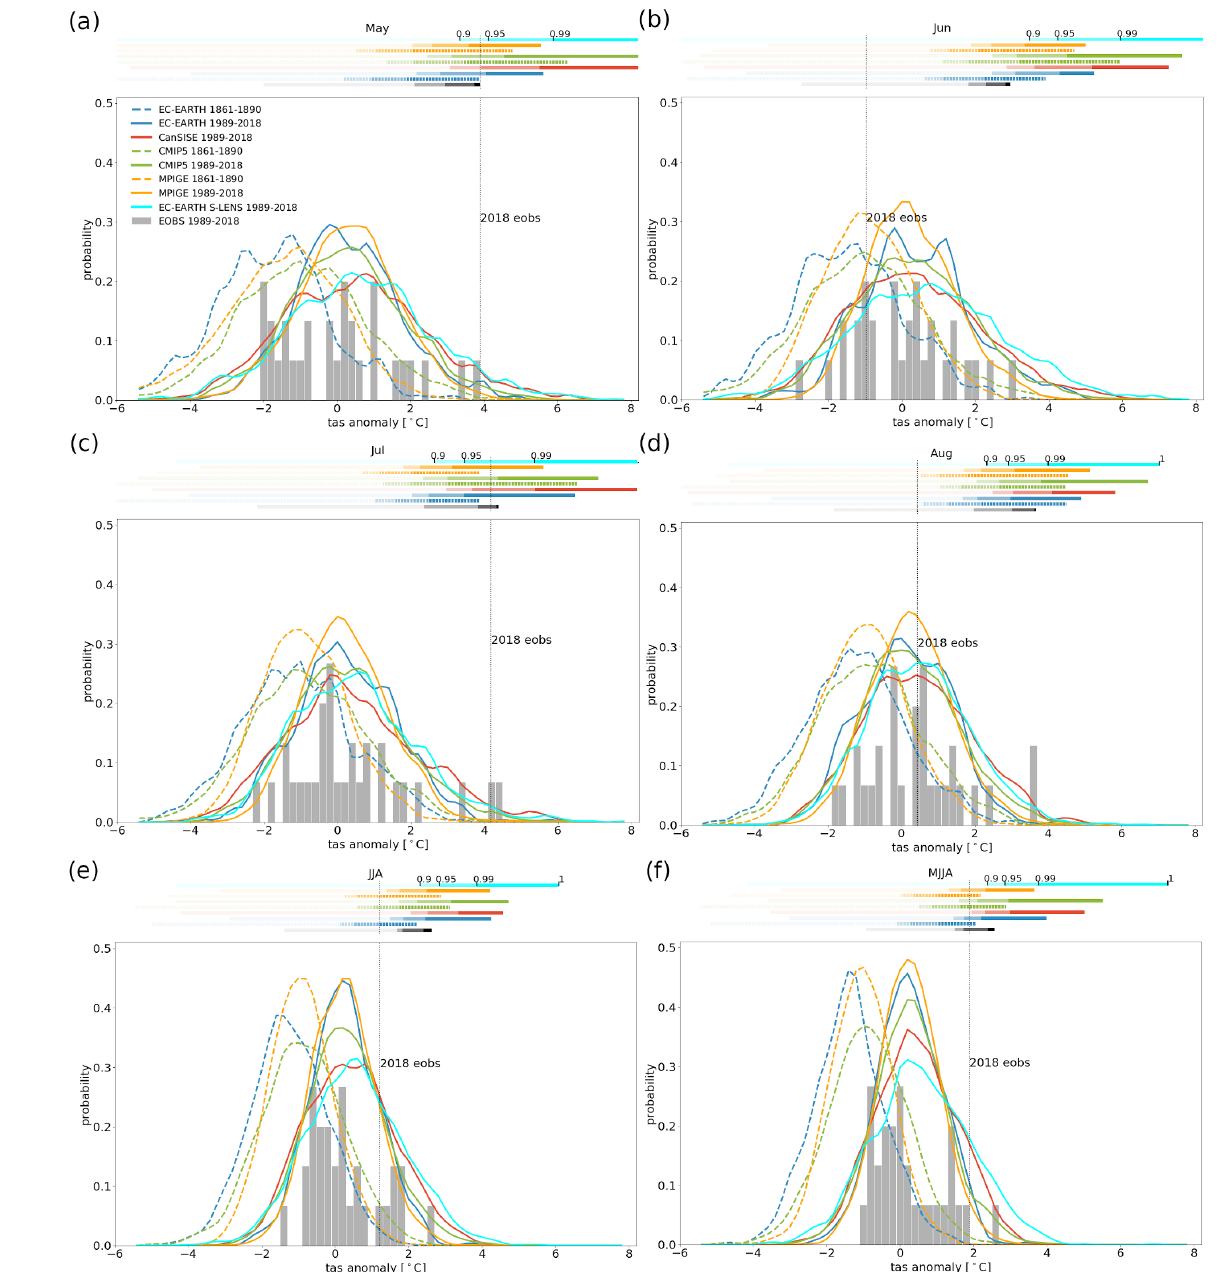
Figure 3. As in Fig. 2 but for the northern half of Sweden (as defined in Fig. S1